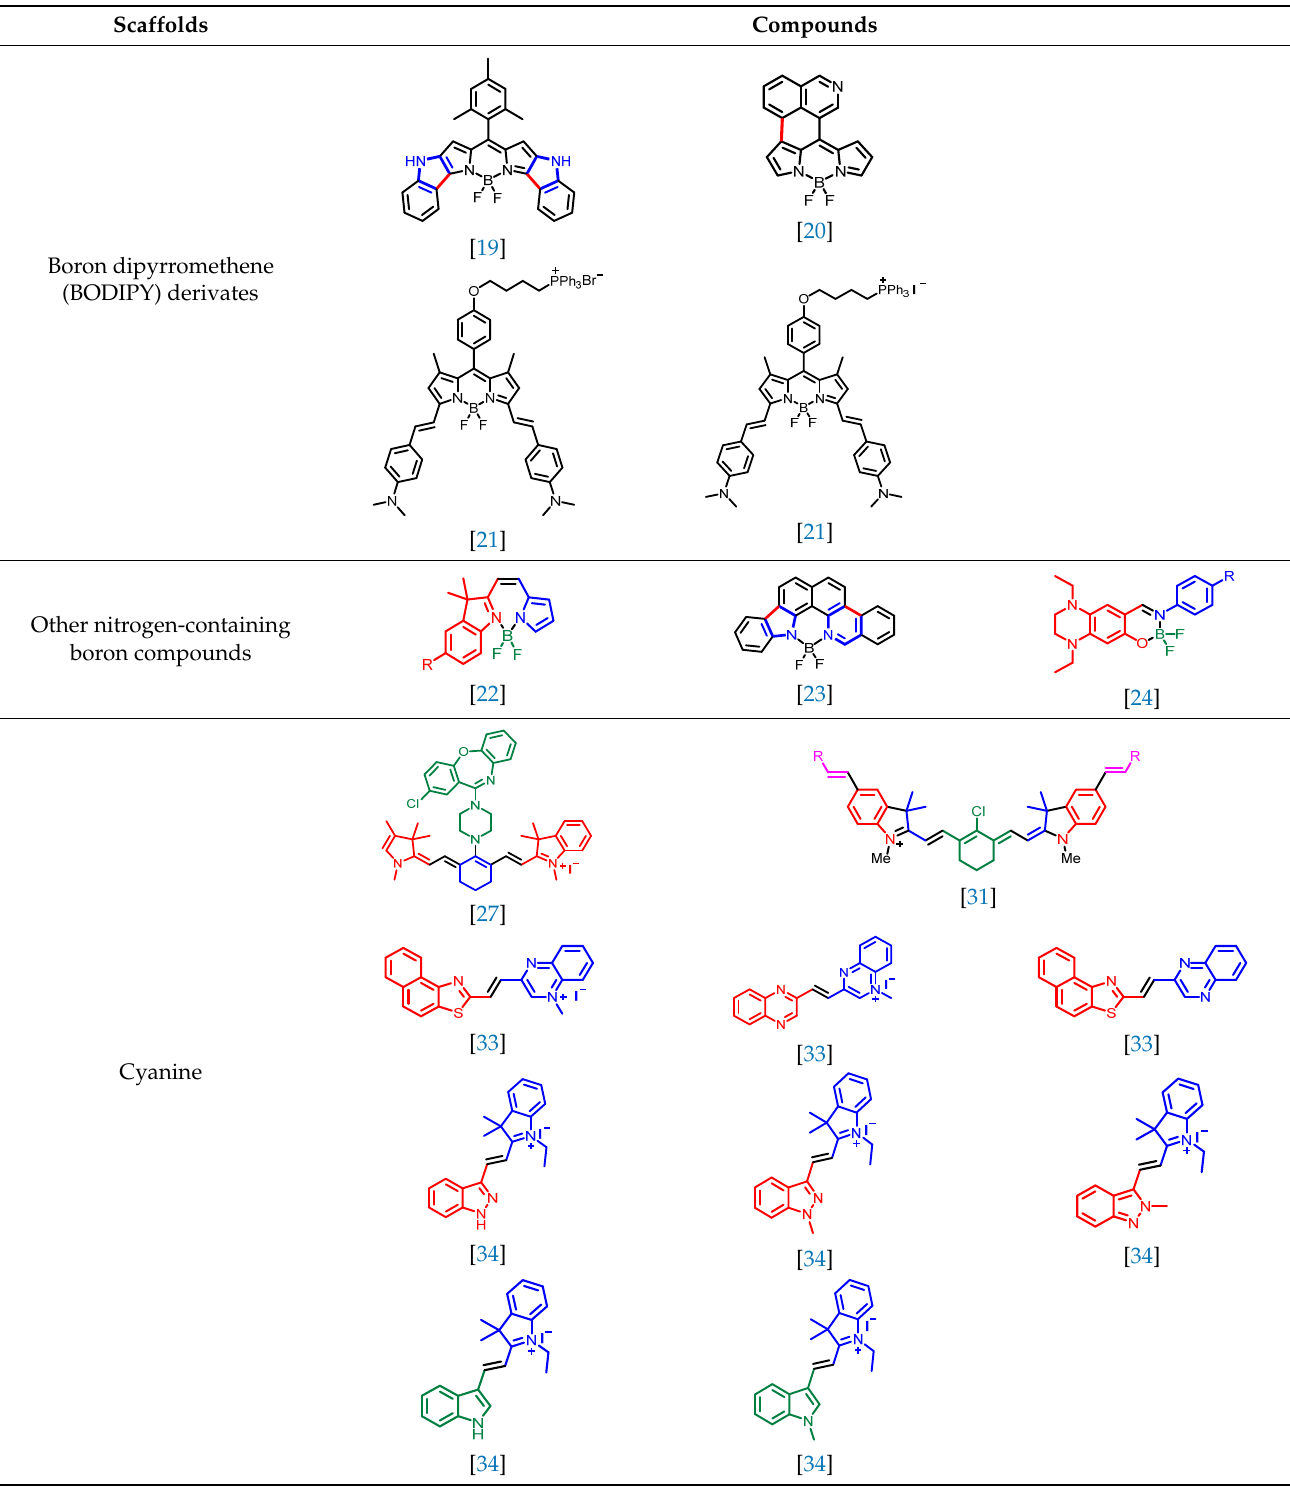
Table 1. Summary of the N -heterocyclic small molecules.